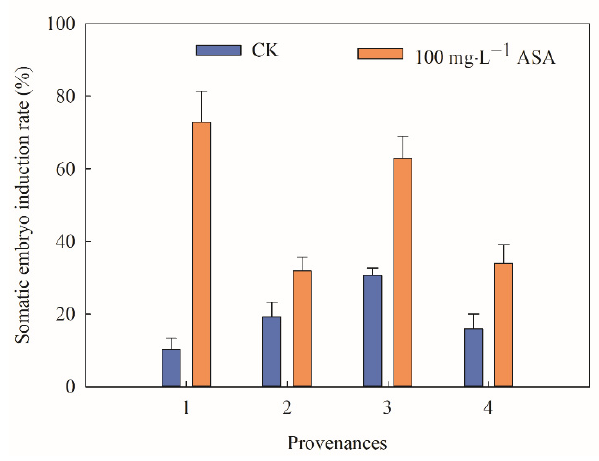
Figure 2. Effects of 0 and 100 mg·L − 1 ASA treatments on somatic embryogenesis of Fraxinus mands- hurica from different provenances. The x -axis represents the different provenances of F. mandshurica , and the y -axis represents the somatic embryo induction rate (%). Error bars show the standard error of the mean.